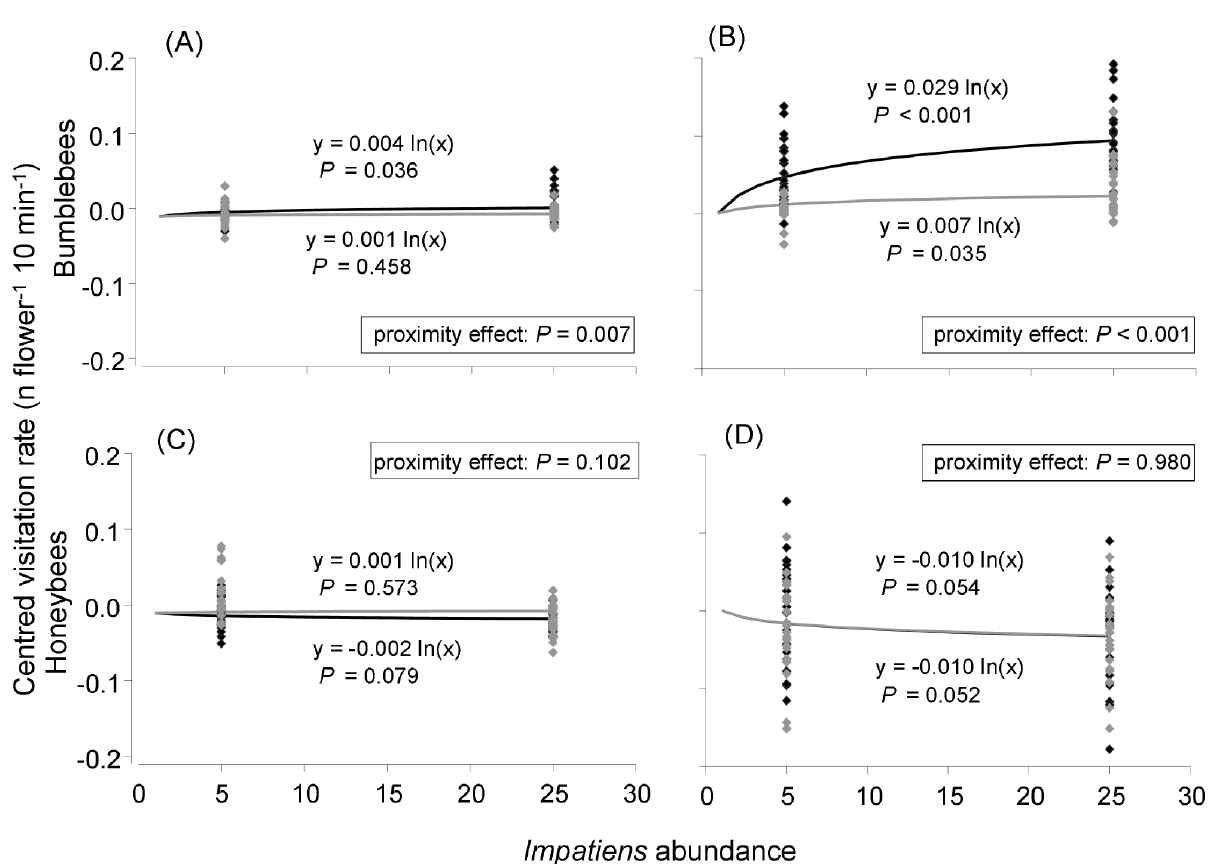
F IG . 4. Impact of the proximity (black diamonds: 0 m distance, grey diamonds: 15 m distance) of I. glandulifera on the effect of its abundance on the centred visitation rate in 2008 for both native plant species, A. napellus (A) & (C) and E. angustifolium (B) & (D) , and for the two main pollinator categories (bumblebees and honeybees). For each combination of plant species, pollinator category and proximity level, model predictions are represented by a solid line and described by the equation with the corresponding P- value indicating significance. Another P -value indicates the significance of the proximity